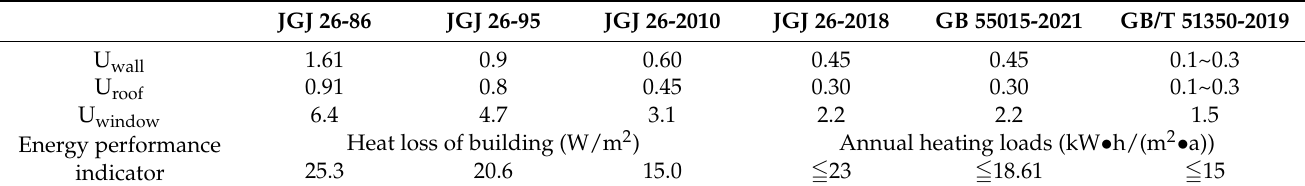
Figure 1. Improvements in energy efficiency in Chinese building standards. Table 1. Comparison of series standards for energy-efficient design of residential buildings in Bei- jing.